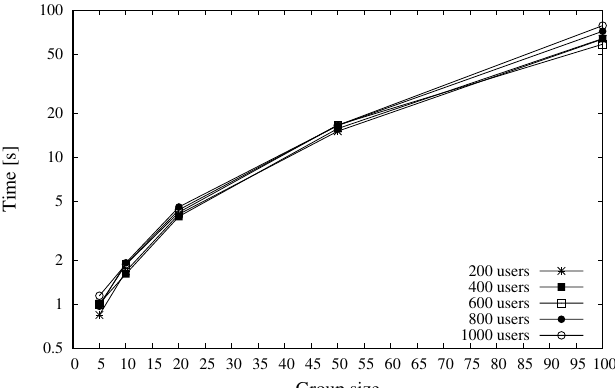
Figure 13. Computing time versus group size, for different values of the number of users in the com- munity.